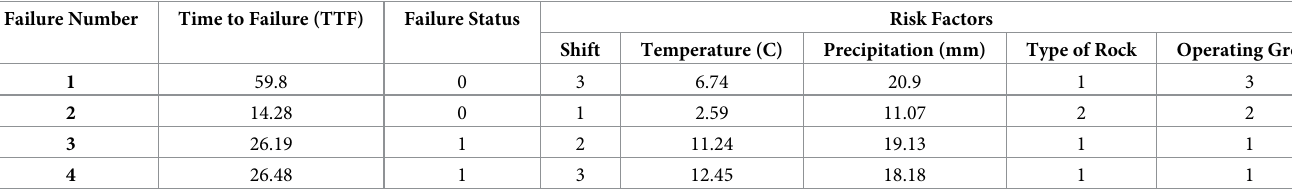
Table 2. Some of the TTF data associated with Caterpillar excavator risk failure factors. Failure Number Time to Failure